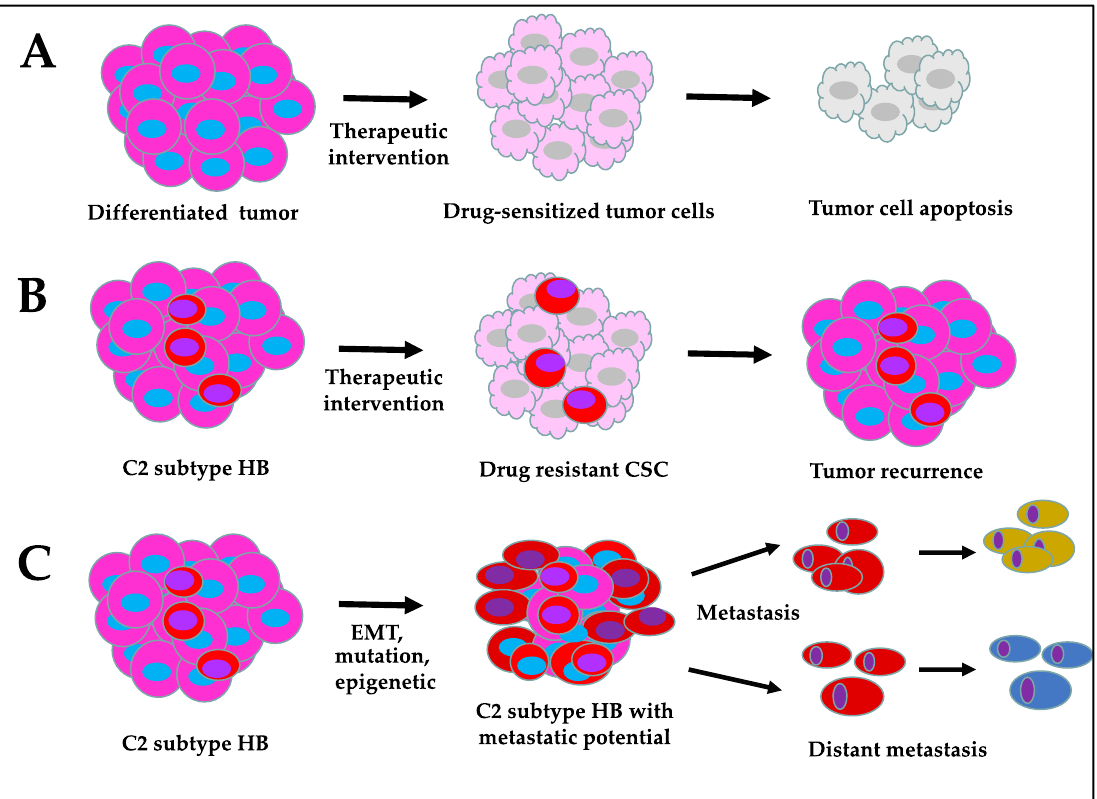
Figure 3. Characteristics of cancer stem cell-enriched hepatoblastoma compared to differentiated tumor: ( A ) drug-sensitive differentiated tumor cells, ( B ) drug resistant CSC in HB, and ( C ) CSC-enriched metastatic HB.